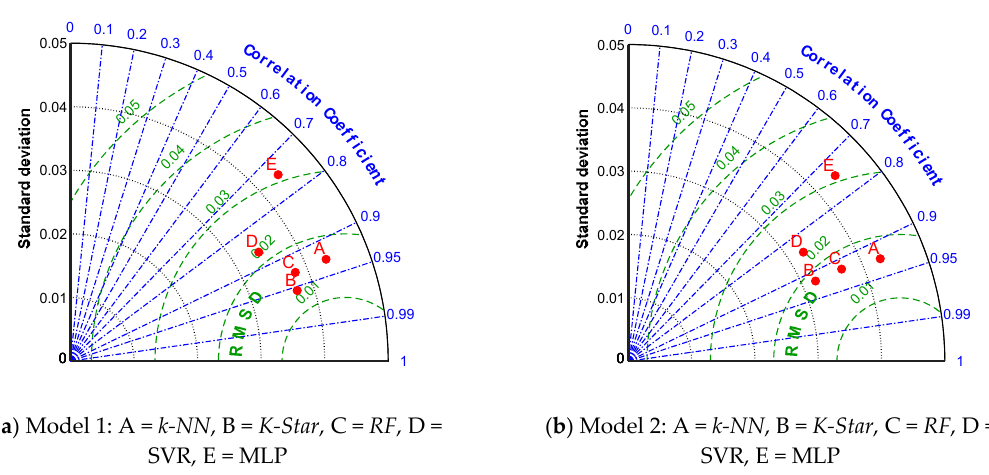
Figure 14. Taylor diagrams for Model 1 ( a ) and Model 2 ( b ) variants.